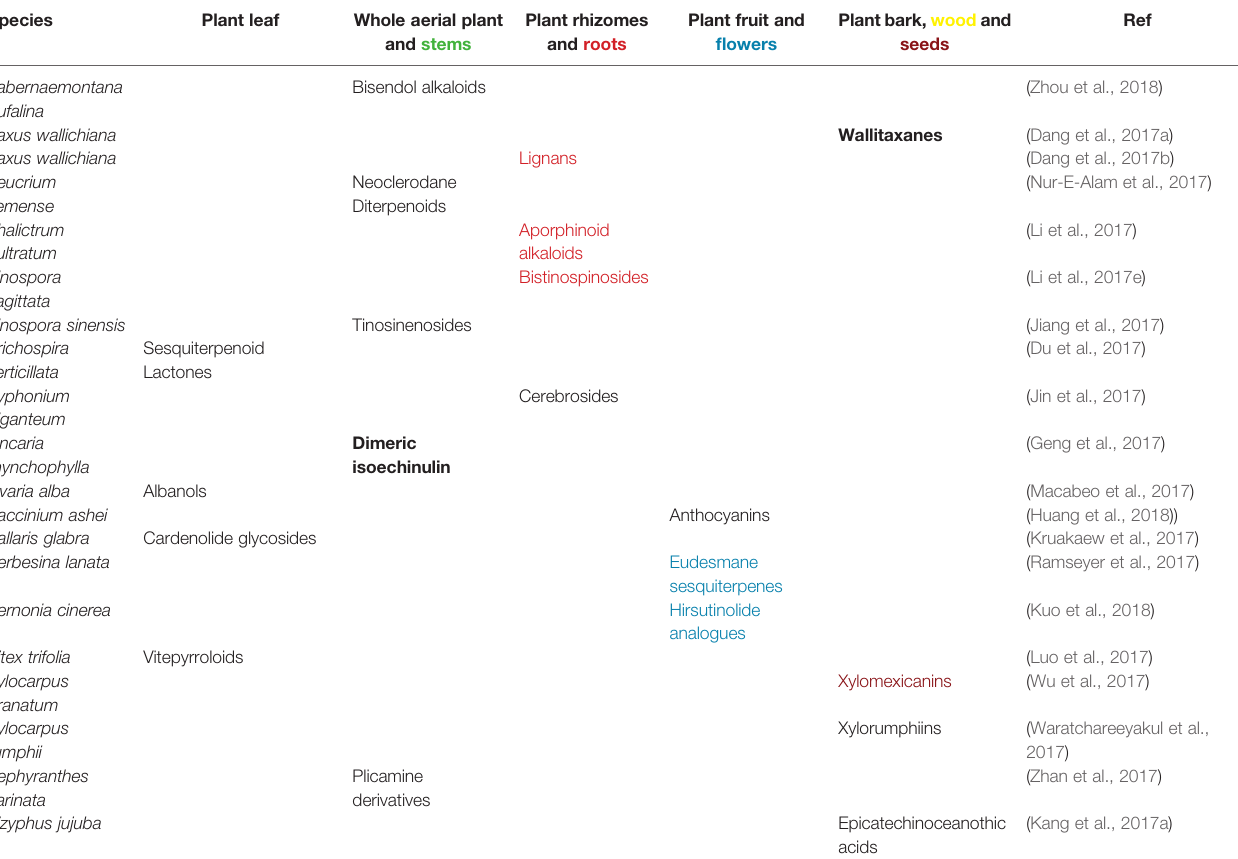
expressing different